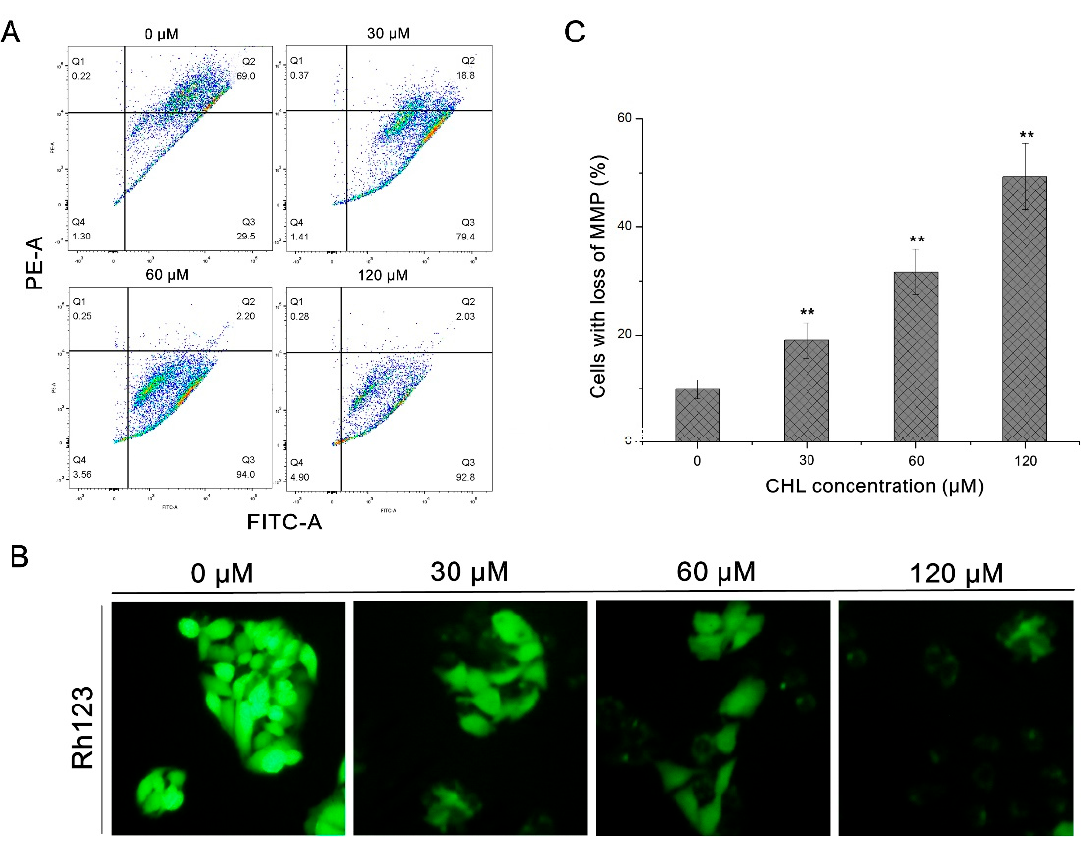
Figure 3. Analysis of MMP loss in HepG2 cells after treatment with CHL. ( A ): Analysis of JC-1 staining by flow cytometry. ( B ): Analysis of Rh123 staining by epifluorescence (200 × ). ( C ): Quantification levels of MMP loss. ** p ≤ 0.01 vs. the negative control.